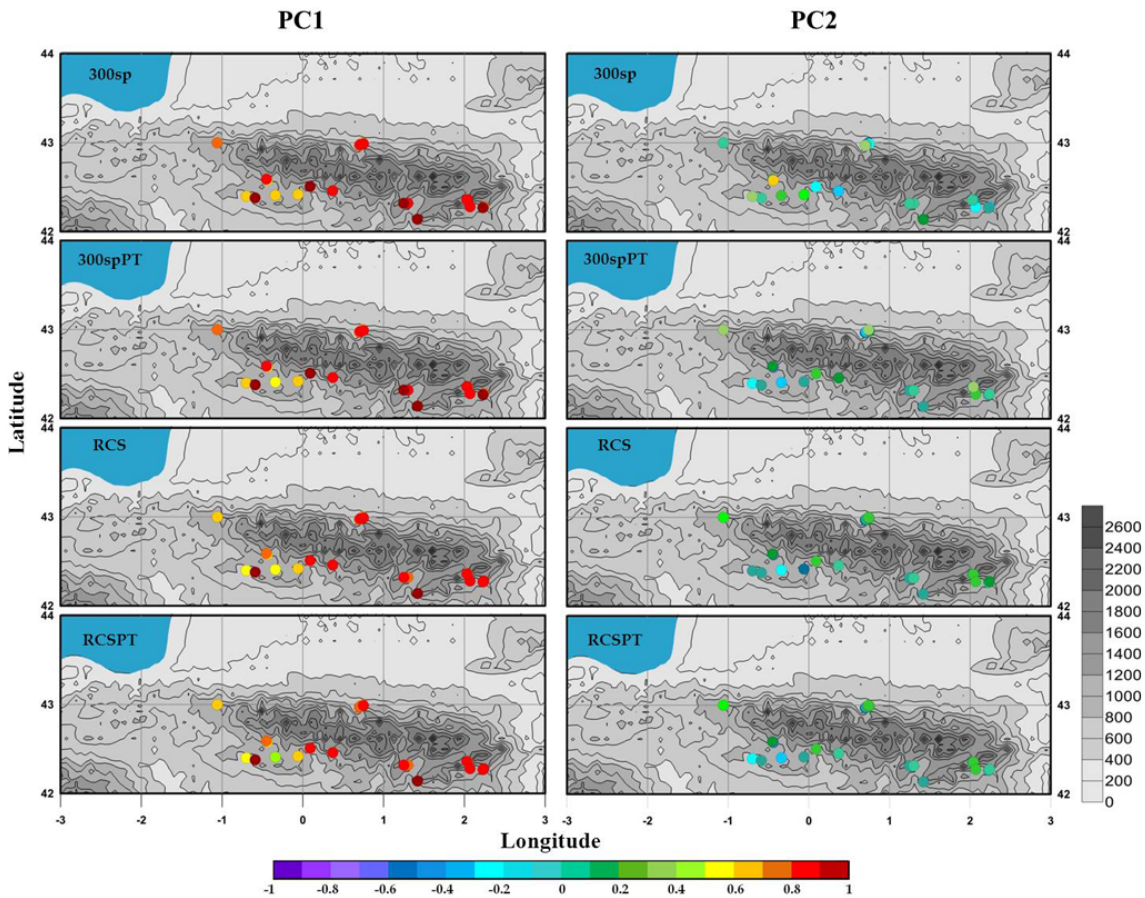
Fig. 4. EOF maps corresponding to the first (PC1) and second (PC2) principal component for each of the standardization methods used for building the site MXD chronologies: 300sp, 300spPT, RCS and RCSPT. The principal component analysis (PCA) was run for the common period